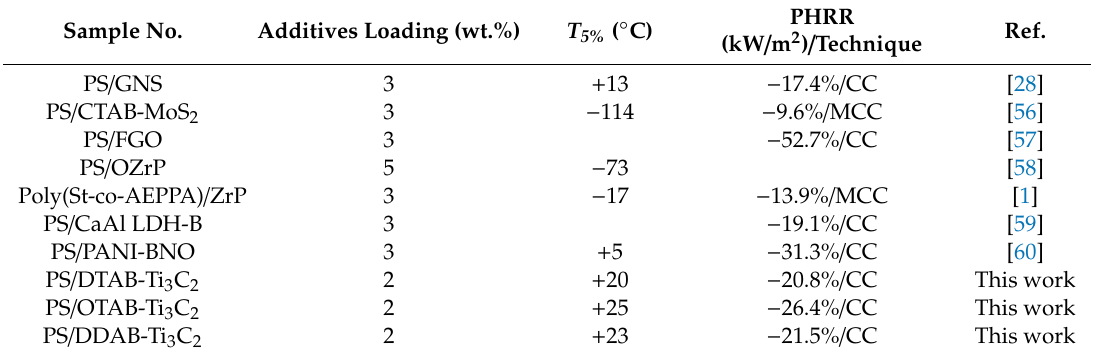
Table 3. Thermal stability and flame retardant performance of PS nanocomposites reported in previous work and this work (CC: cone calorimeter; MCC: micro-combustion